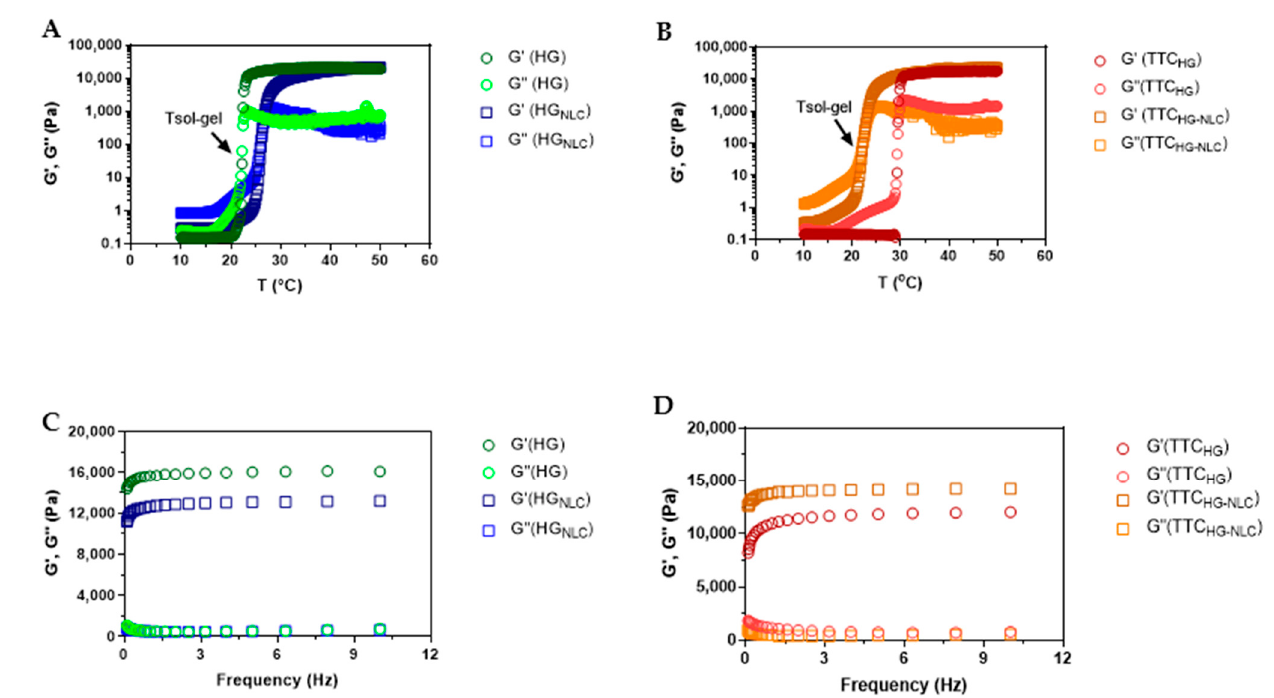
Figure 2. Rheology measurements. Storage modulus (G’) and loss modulus (G”): as a function of temperature for ( A ) HG and HG + NLC and ( B ) TTC NLC-HG4% and TTC HG4% ; and as a function of frequency for ( C ) HG and HG + NLC and ( D ) TTC NLC-HG4% and TTC HG4 , measured at 32.5 °C.